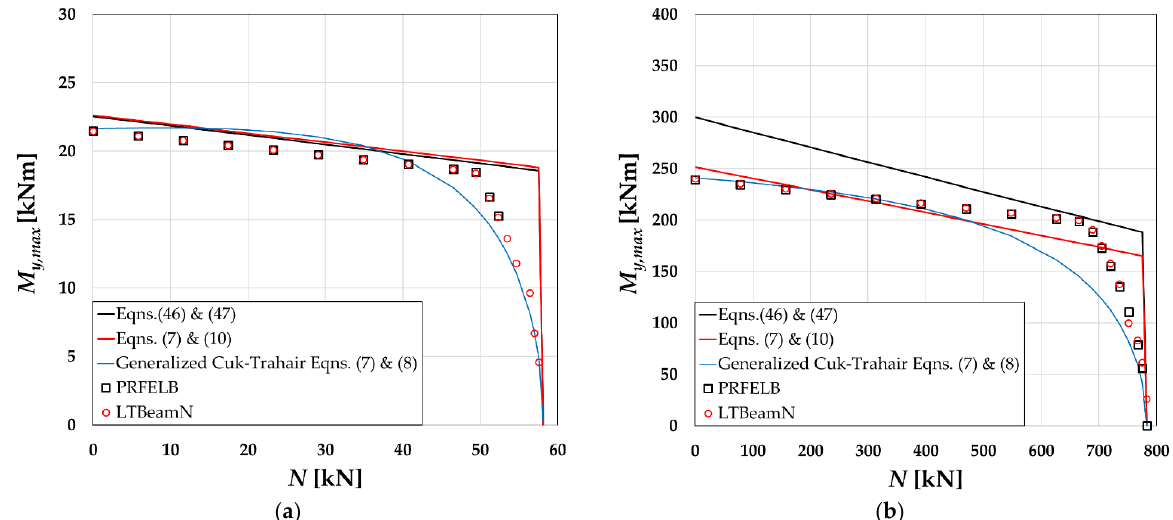
the antisymmetric in-plane loading systems are of concern for the verification. The same member length as well as the loading and section types are concerned. A shear-center uniformly distributed load over the half length of the member (Case 3: i = 1 but ψ q , i = − 1) and a concentrated load applied at the shear center one quarter of the beam-length from both supports (Case 4: j = 1 but ψ Q , j = − 1) are dealt with. The results are presented in Figures 6 and 7, respectively.